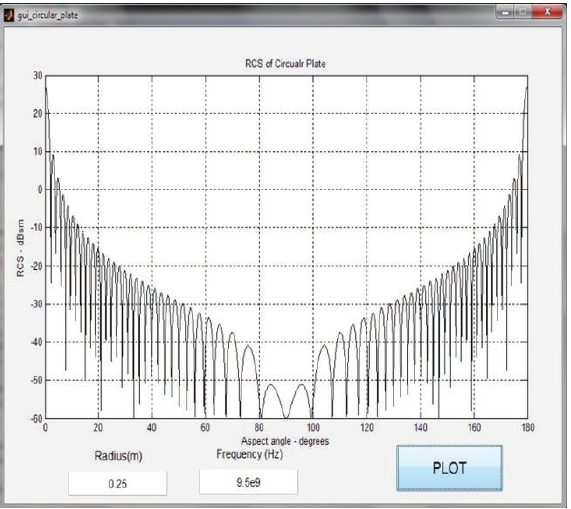
Figure 16: GUI for RCS of circular